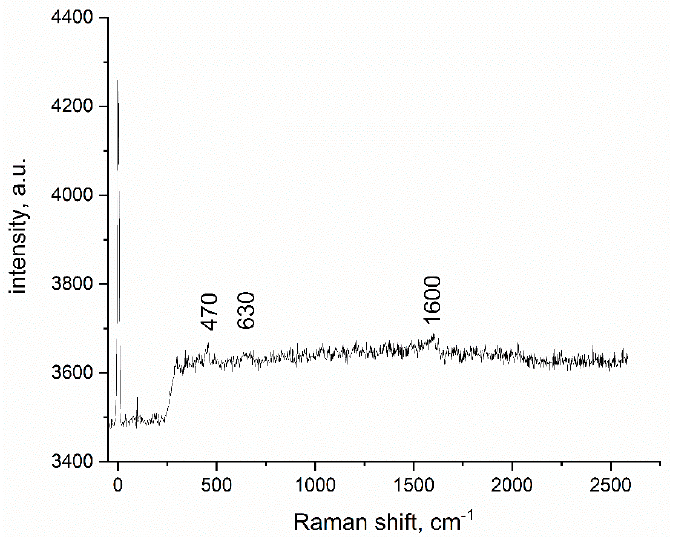
Figure 2. Raman spectra of xerogel sample, SiO 2 FexOy, with laser excitation source (514 nm).